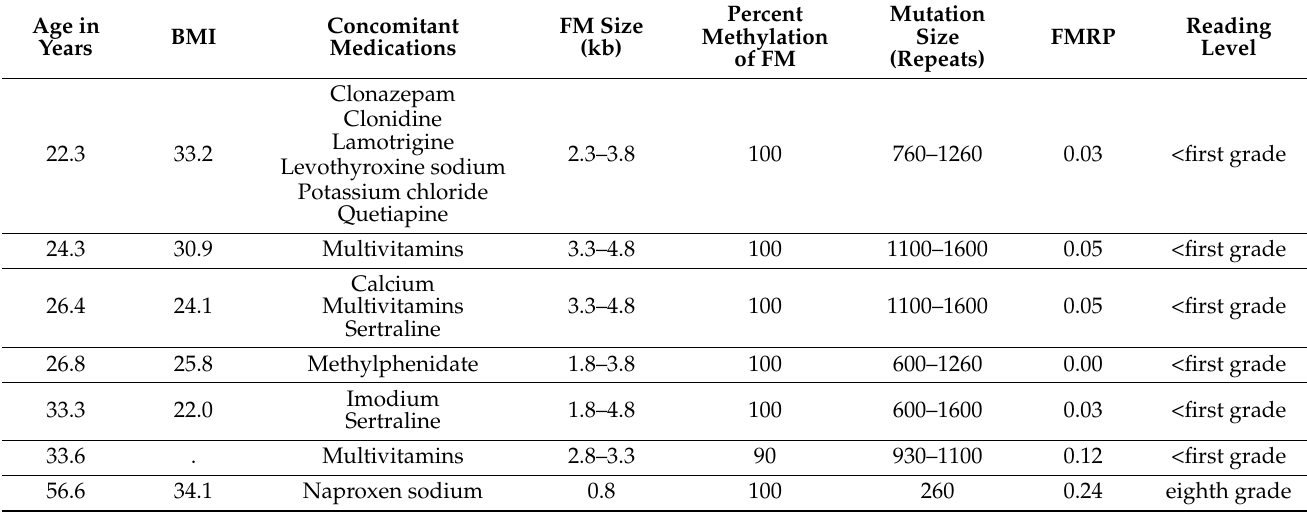
Table 1. Clinical characteristics of Caucasian male participants with the full mutation (FM) or allele